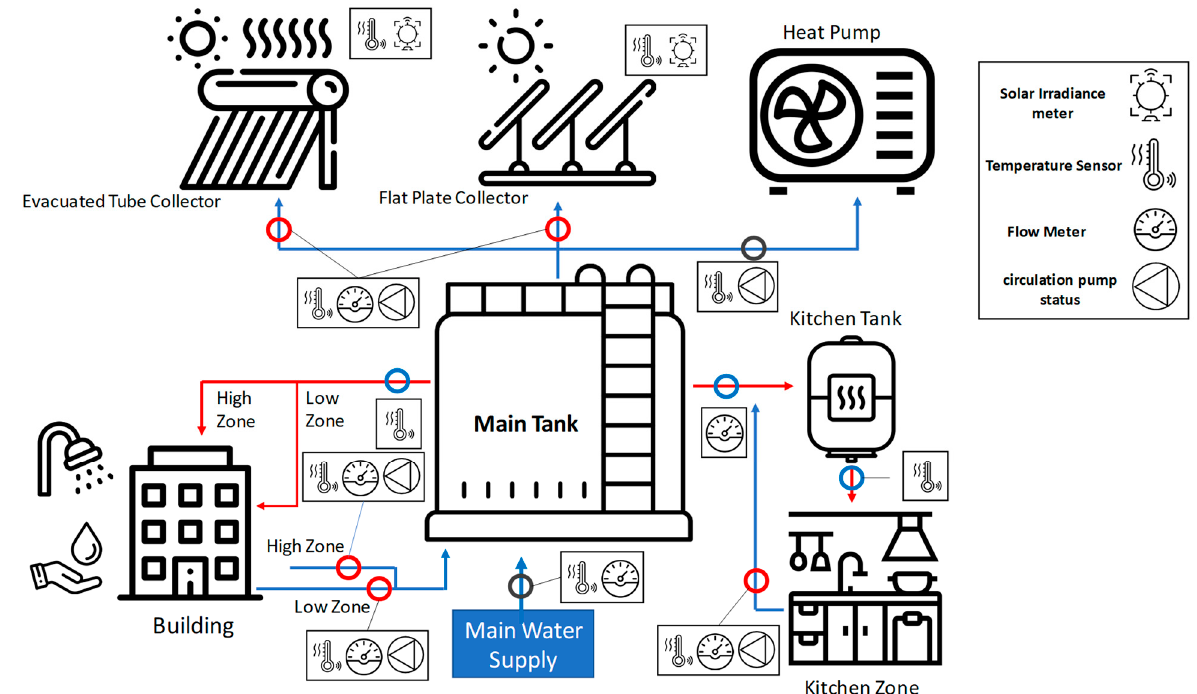
Figure 6. IoT of solar water heating systems in Singapore [60].